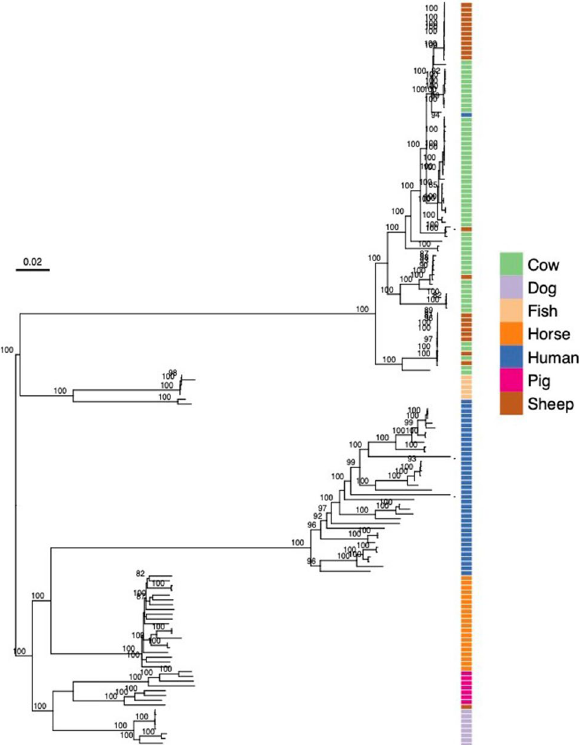
Figure 4. Midpoint-rooted phylogenetic tree of Streptococcus dysgalactiae subsp. dysgalactiae (n = 78) and Streptococcus dysgalactiae subsp. equisimilis (n = 78) included in the study. Colours on the side of each plot indicate the origin of the isolate. Scale indicates substitutions per site. The numbers above the branches are support values from 100 bootstrap